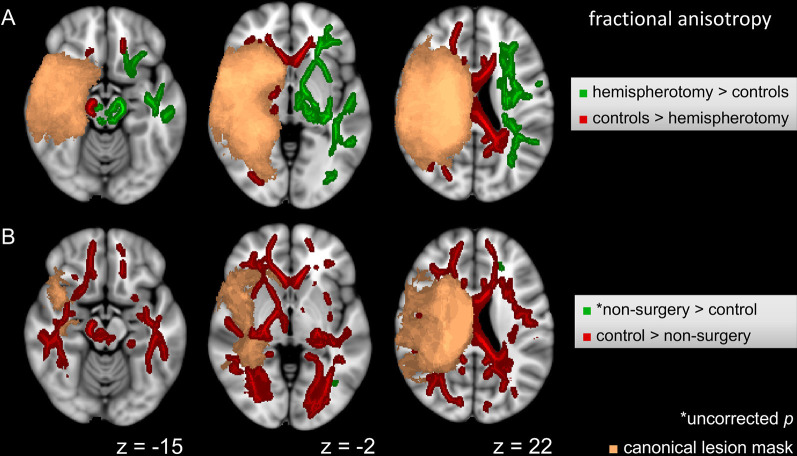
Intergroup FA differences. (A) Voxel-wise post hoc tests in FA between hemispherotomy group and healthy controls. (B) Voxel-wise post hoc tests in FA between non-surgery group and healthy controls. If not indicated otherwise, tests were corrected for family-wise error and p < 0.05. z indicates axial coordinate in MNI standard space. Please note that the canonical lesions masks differ between the post hoc tests as they are built out of the individual lesion masks of the respective groups contrasted. Skeletonized results were thickened for visualization purposes.